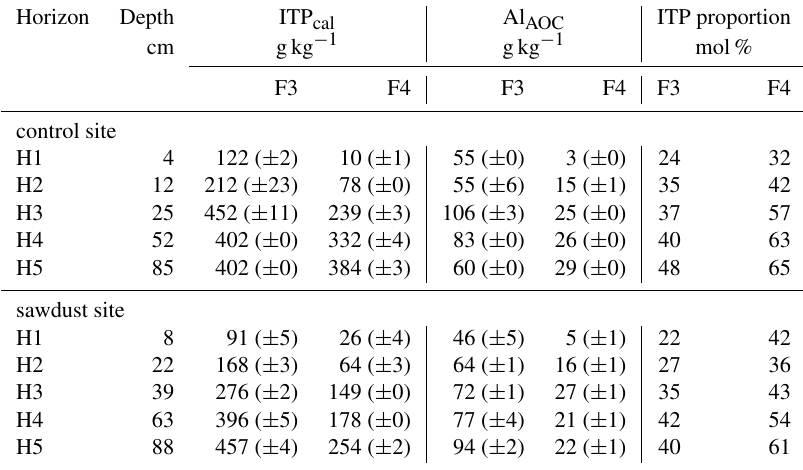
Table 3. Concentrations of imogolite-type phases (ITP cal ), Al in Al–OM complexes (Al AOC ), and molar proportions of imogolite-type phases on short-range-ordered phases (ITP proportion) in F3 and F4, as calculated with Eqs. (3) to (5). Data are presented as means, and ranges in parenthesis.